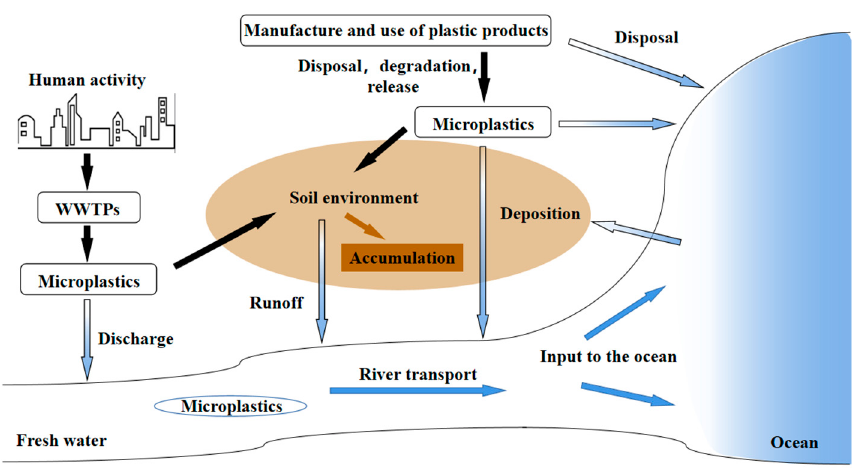
Figure 2. Transportation of microplastic particles within and between anthropogenic, terrestrial, freshwater, and marine environment. Reprinted with permission from Ref. [28]. 2017, Horton, A.A.; Walton, A.; Spurgeon, D.J.; Lahive, E.; Svendsen,